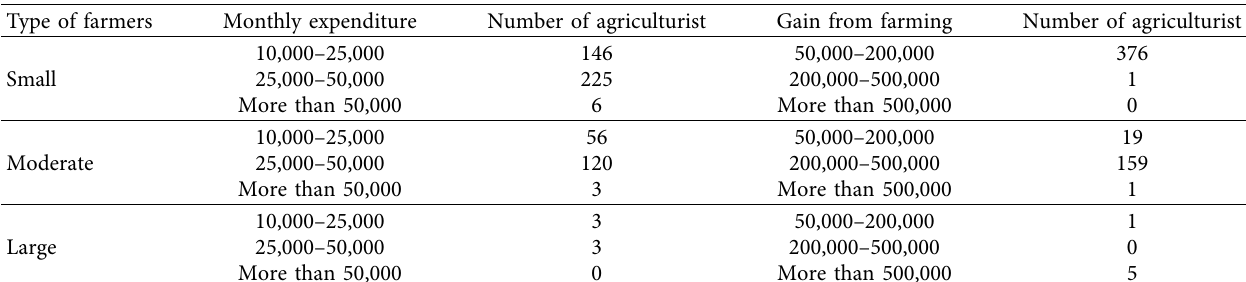
Figure 13: Farmers type versus expenses per month and gain from farming. Table 5: Expense of ranchers and their